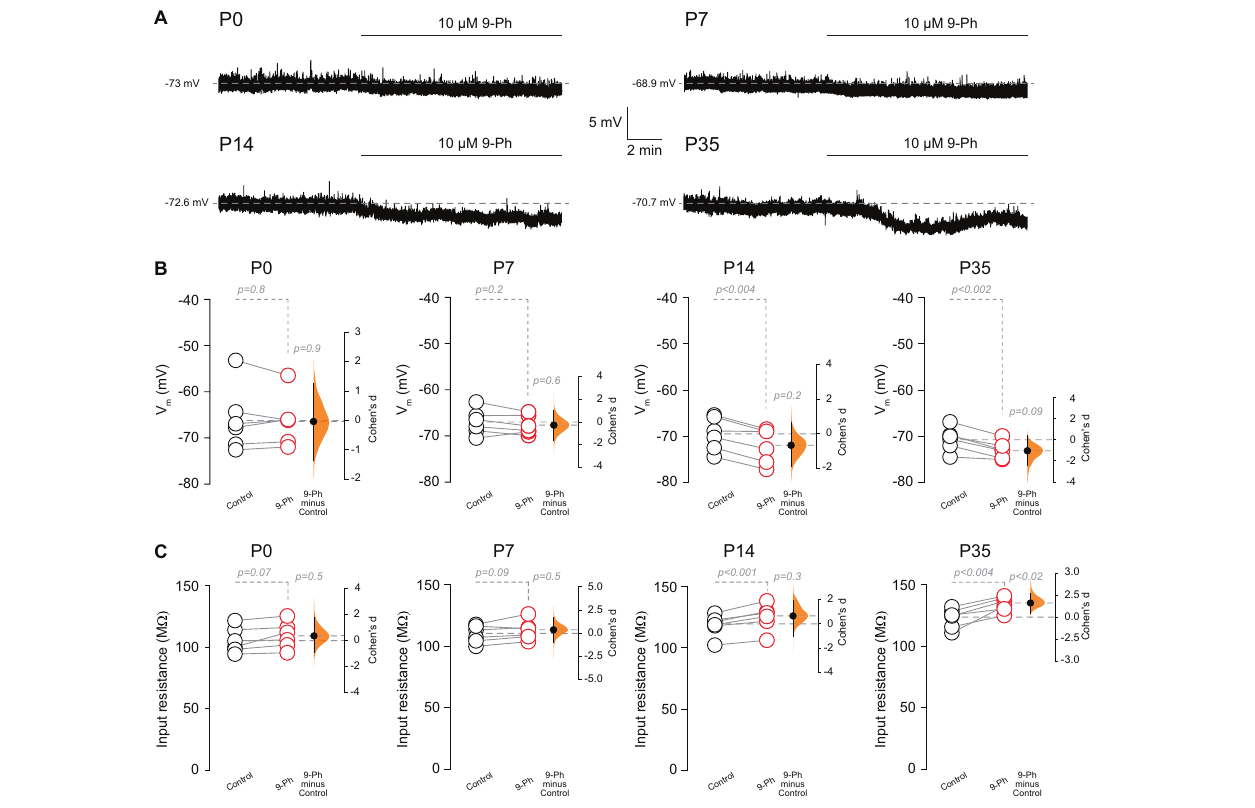
FIGURE 4 | TRPM4 inhibition hyperpolarizes CA1 pyramidal neurons during postnatal development. (A) Representative perforated-patch voltage trace recorded in pyramidal neurons showing the effect of 10 µ M 9-Ph at P0, P7, P14, and P35. (B) Summary plots showing resting membrane potential and the effect of 10 µ M 9-Ph at P0 ( n = 6), P7 ( n = 6), P14 ( n = 6), and P35 ( n = 6). (C) Summary plots showing the effect of 9-Ph on the input resistance at P0 ( n = 6), P7 ( n = 6), P14 ( n = 6), and P35 ( n = 6; statistical difference were determined using a one-way ANOVA, p -values are show above each group). On the right side of each plot the paired mean difference between the conditions is shown; the mean difference is depicted as a dot; the 95% confidence interval is indicated by the end of the vertical error bar. Statistical differences were evaluated using paired t -test and p -values are shown above. Each point corresponds to an individual mouse (1 slice per